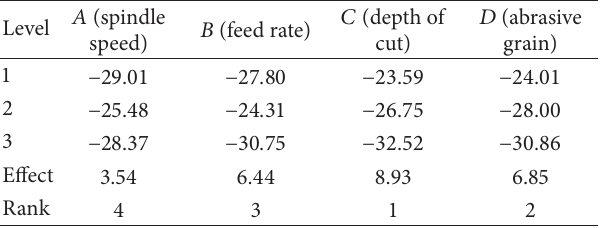
Table 5: 𝑆/𝑁 ratio response for cracking percentage.